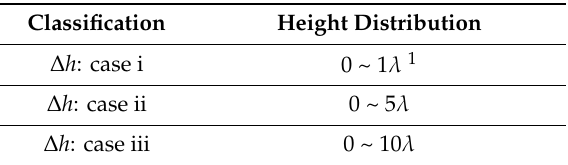
Table 3. Random distribution of the reflection surface height fluctuation ∆ℎ .